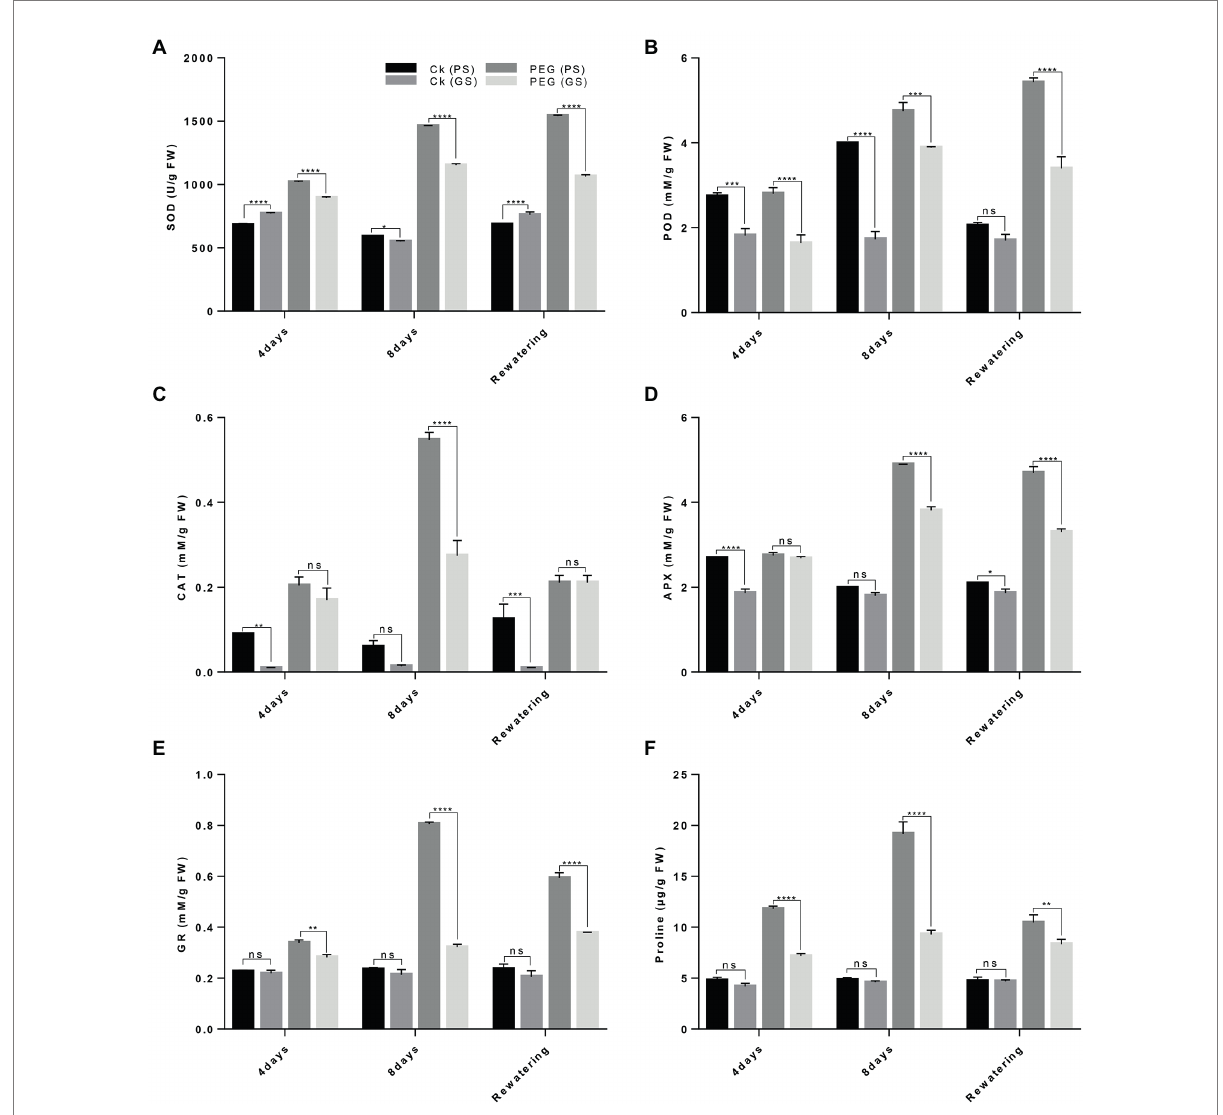
FIGURE 7 Purple and green stem Brassica napus plants under drought (10% PEG-6000), (A) superoxide dismutase (SOD), (B) peroxidase (POD), (C) catalase (CAT), (D) ascorbate peroxidase (APX), (E) glutathione reductase (GR), and (F) proline content of purple and green stem, respectively. Different symbols represents significance level as * p = 0.05, ** p = 0.01, *** p = 0.001, **** p = 0.0001. ns,